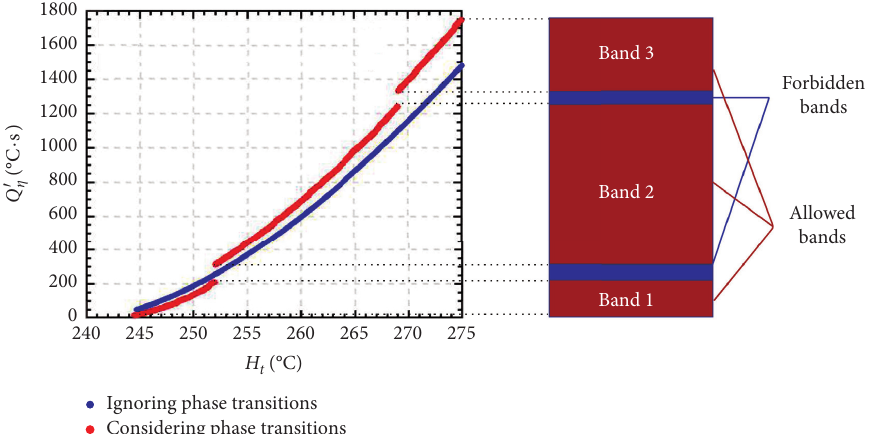
Figure 10: The banded distribution of the heating factor Q ′ min